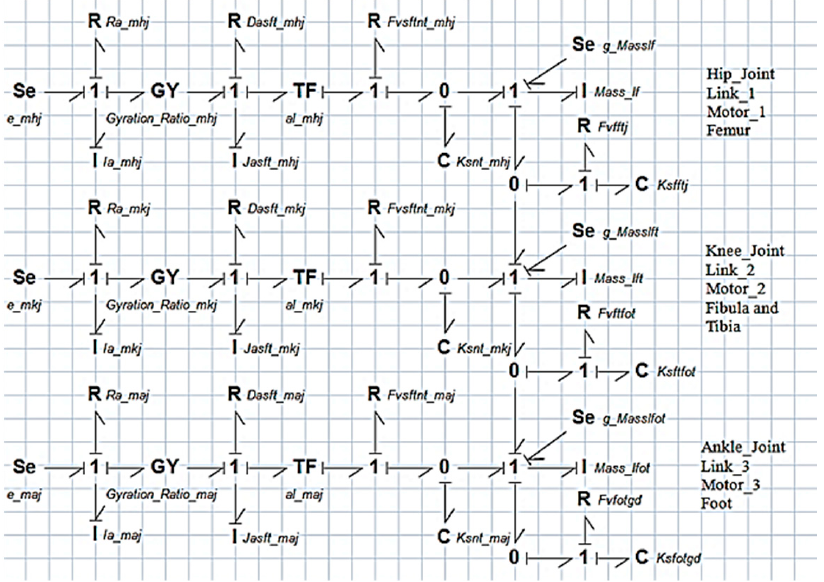
Figure 3. Bond graph model of lower limb rehabilitation exoskeleton using 20-sim.